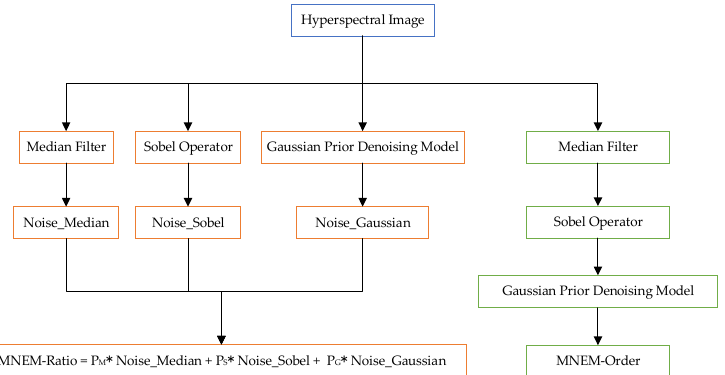
Figure 1. Flowchart of Noise Estimation. 𝑃 (cid:3014) , 𝑃 (cid:3046) and 𝑃 (cid:3008) are the coefficients of Noise_Median, Noise_Sobel, and Noise_Gaussian in mixed noise estimation model (MNEM)-Ratio. For the MNEM-Ratio, mean spectral angle distance (MSAD), which is expressed as in Equation (24), is used as the evaluation criteria to determine 𝑃 (cid:3014) ,𝑃 (cid:3020) , and 𝑃 (cid:3008) . In evalu- ating the noise estimation performance, the smaller the value of MSAD, the better the denoised results. The procedure is shown in Algorithm 1. Algorithm 1. The procedure of determining 𝑃 (cid:3014) , 𝑃 (cid:3020) and 𝑃 (cid:3008) in MENM-Ratio Input: hyperspectral image Y. Step 1: input Y into the median filter to obtain the median filter denoised image Y_Median. Step 2: Sobel operator is used in Y to get the Sobel denoised image Y_DeNoise_Sobel = Y − Y_Sobel. Step 3: Y is input into the Gaussian prior denoising model to obtain the denoised image Y_Gaussian. Step 4: calculate the MSAD values 𝑀𝑆𝐴𝐷_𝑀𝑒𝑑𝑖𝑎𝑛 , 𝑀𝑆𝐴𝐷_𝑆𝑜𝑏𝑒𝑙 and 𝑀𝑆𝐴𝐷_𝐺𝑎𝑢𝑠𝑠𝑖𝑎𝑛 between the input image and the denoised images Y_Median, Y_DeNoise_Sobel and Y_Gaussian. Step 5: take the reciprocals, that is 𝑀𝑆𝐴𝐷 (cid:3014) = 1/𝑀𝑆𝐴𝐷_𝑀𝑒𝑑𝑖𝑎𝑛 , 𝑀𝑆𝐴𝐷 (cid:3020) = 1/ 𝑀𝑆𝐴𝐷_𝑆𝑜𝑏𝑒𝑙 and 𝑀𝑆𝐴𝐷 (cid:3008) = 1/𝑀𝑆𝐴𝐷_𝐺𝑎𝑢𝑠𝑠𝑖𝑎𝑛 . Step 6: 𝑃 (cid:3014) = (cid:3014)(cid:3020)(cid:3002)(cid:3005) (cid:3262) (cid:3014)(cid:3020)(cid:3002)(cid:3005) (cid:3262) (cid:2878)(cid:3014)(cid:3020)(cid:3002)(cid:3005) (cid:3268) (cid:2878)(cid:3014)(cid:3020)(cid:3002)(cid:3005) (cid:3256) , 𝑃 (cid:3020) = (cid:3014)(cid:3020)(cid:3002)(cid:3005) (cid:3268) (cid:3014)(cid:3020)(cid:3002)(cid:3005) (cid:3262) (cid:2878)(cid:3014)(cid:3020)(cid:3002)(cid:3005) (cid:3268) (cid:2878)(cid:3014)(cid:3020)(cid:3002)(cid:3005) (cid:3256) and 𝑃 (cid:3008) = (cid:3014)(cid:3020)(cid:3002)(cid:3005) (cid:3256) (cid:3014)(cid:3020)(cid:3002)(cid:3005) (cid:3262) (cid:2878)(cid:3014)(cid:3020)(cid:3002)(cid:3005) (cid:3268) (cid:2878)(cid:3014)(cid:3020)(cid:3002)(cid:3005) (cid:3256) . Output: the values of 𝑃 (cid:3014) , 𝑃 (cid:3020) and 𝑃 (cid:3008) . To evaluate the noise estimation performance of the MNEM, we apply the proposed method to each band in HSI. The following evaluation criteria are used [50,51]: 1. Mean peak signal-to-noise ratio (MPSNR) 𝑀𝑃𝑆𝑁𝑅 = 1 𝑀 (cid:3533) 𝑃𝑆𝑁𝑅 (cid:3040)(cid:3014) (cid:3040)(cid:2880)(cid:2869)